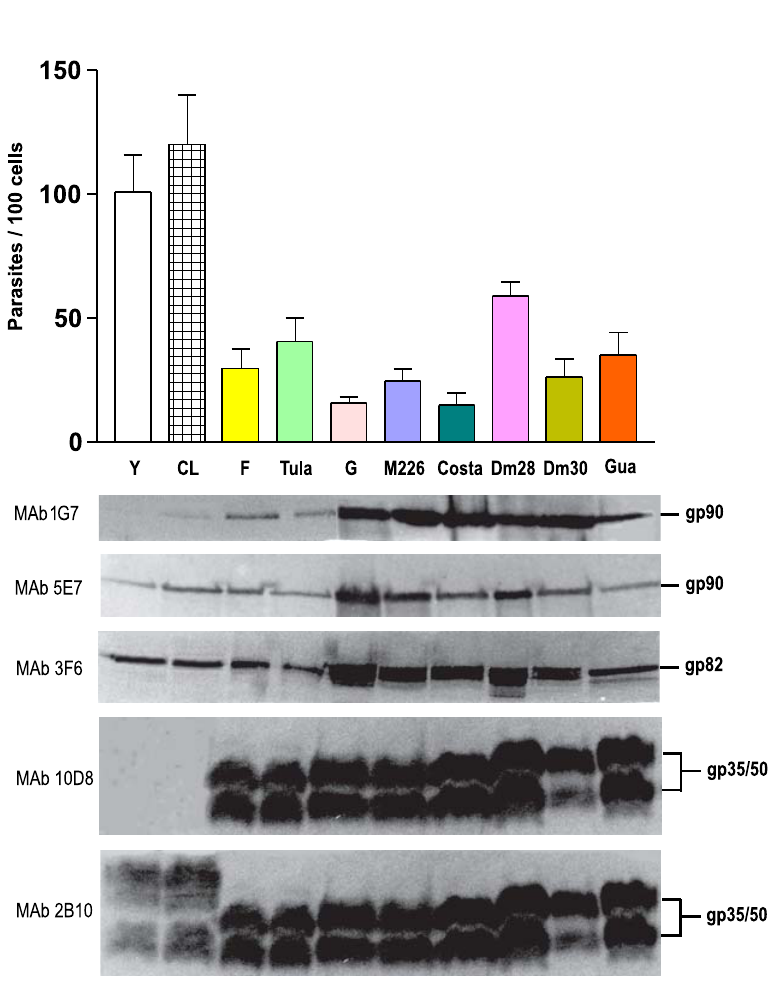
Fig. 1 – Mammalian cell invasion by MT of different T. cruzi isolates and profile of surface molecules. In the upper panel is shown the infectivity of MT of the indicated isolates, expressed as the number of internalized parasites per 100 cells, upon incubation ◦ with HeLa cells for 3h at 37 C. The values correspond to the means ± SD of five experiments performed in duplicates, in which at least 500 Giemsa-stained cells were counted. Shown in the lower panel are the profiles of surface molecules identified by monoclonal antibodies directed to gp90, gp82 and